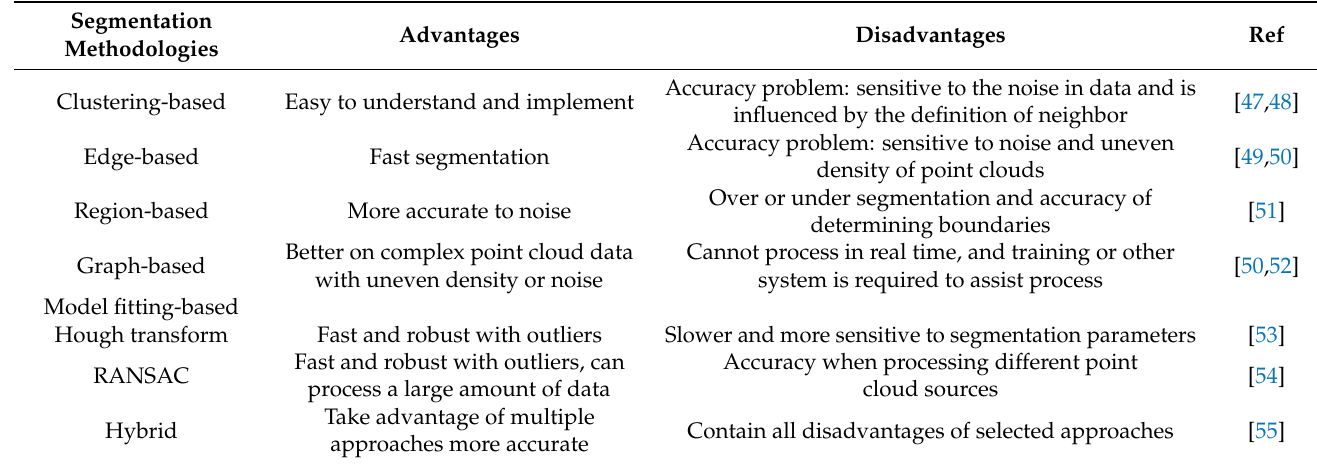
Table 3. Summary of data segmentation methodologies for point cloud data .